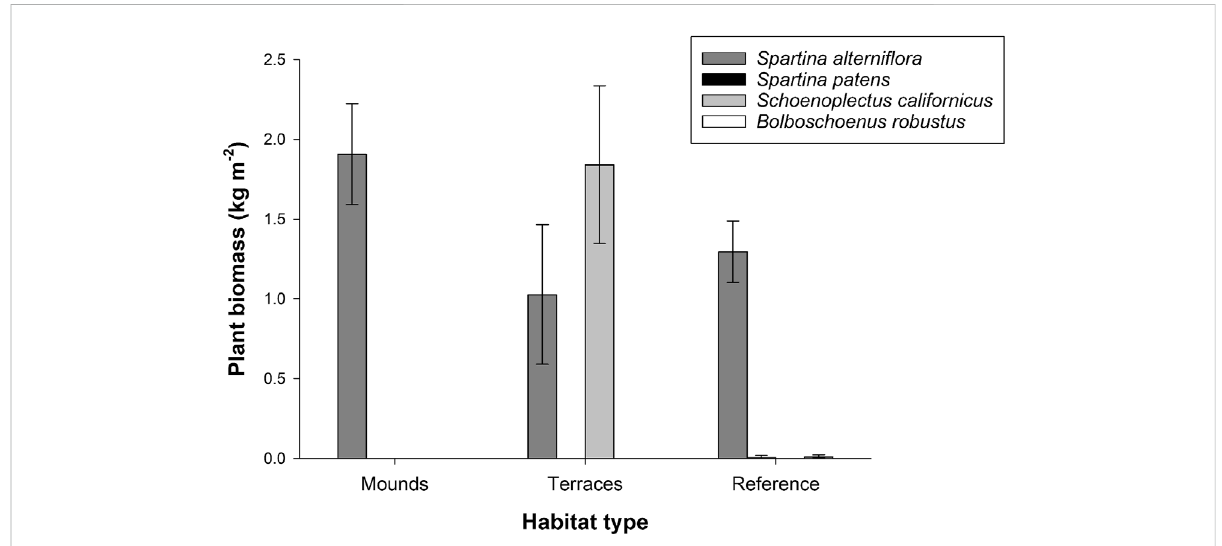
FIGURE 2 Plant biomass at two restored habitat types (mounds and terraces) and in reference areas. Error bars depict standard